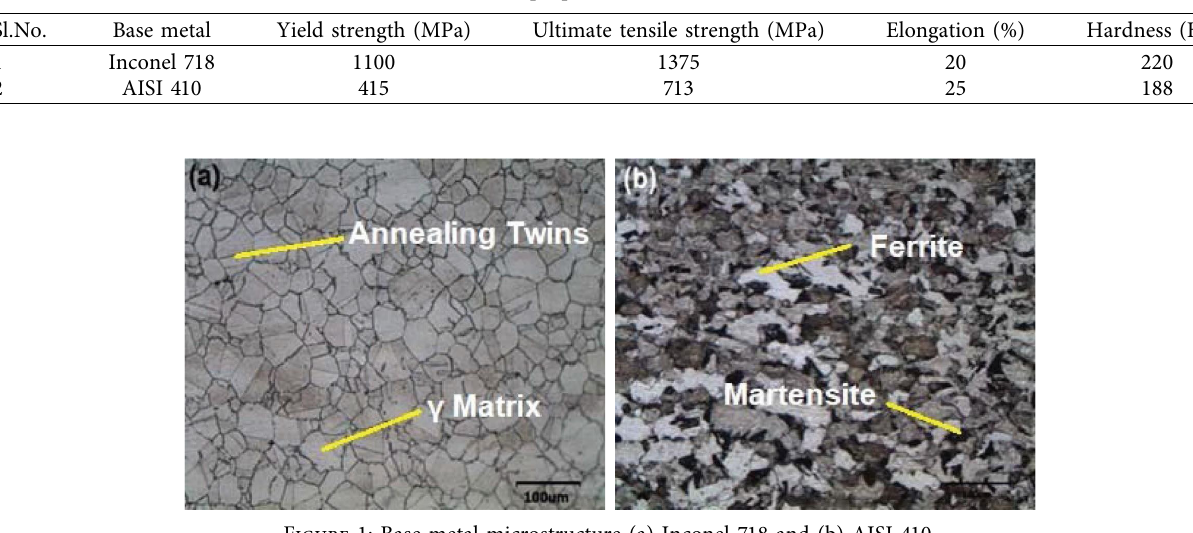
Table 2: Mechanical properties of Inconel 718 and AISI410.